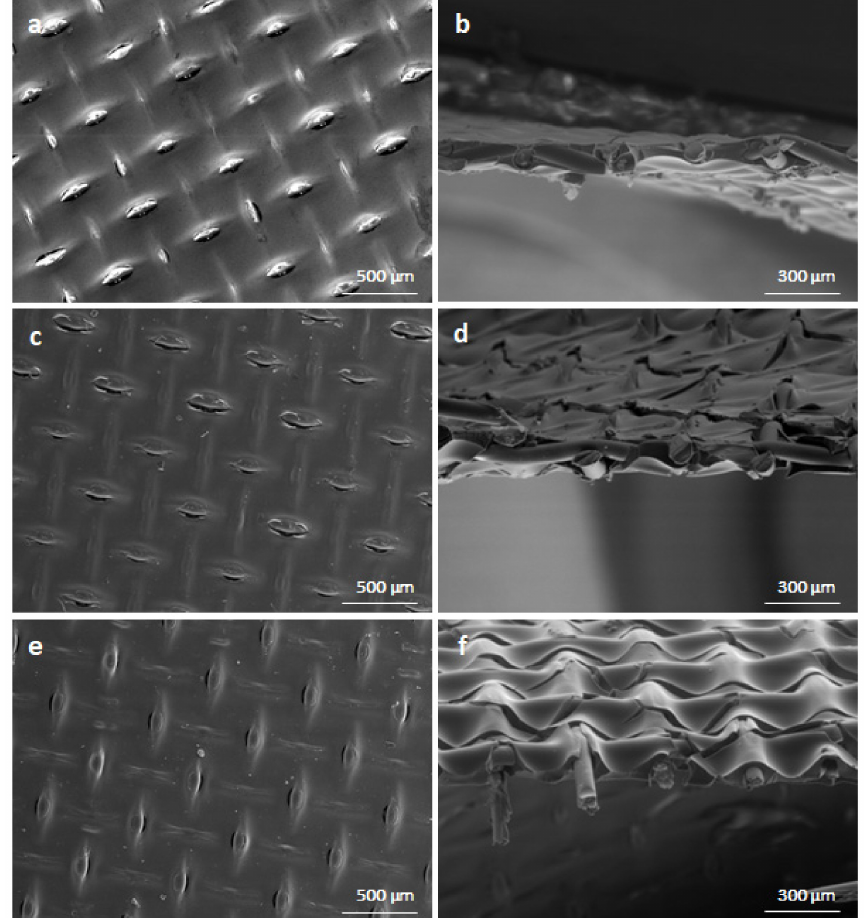
Figure 4. Scanning electron microscopy images detailing membrane state before use (( a ) sur- face, ( b ) cross-section)) and after use (ageing at 25 ◦ C: ( c ) surface, ( d ) cross-section; ageing at 60 ◦ C: ( e ) surface, ( f )